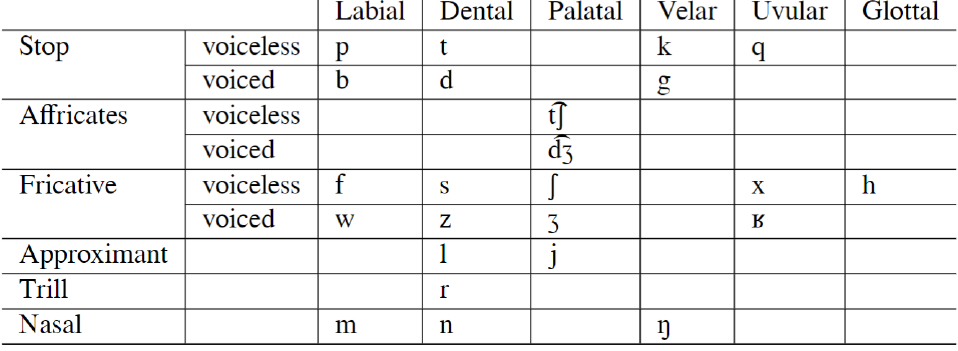
Figure A2. Uyghur consonants.